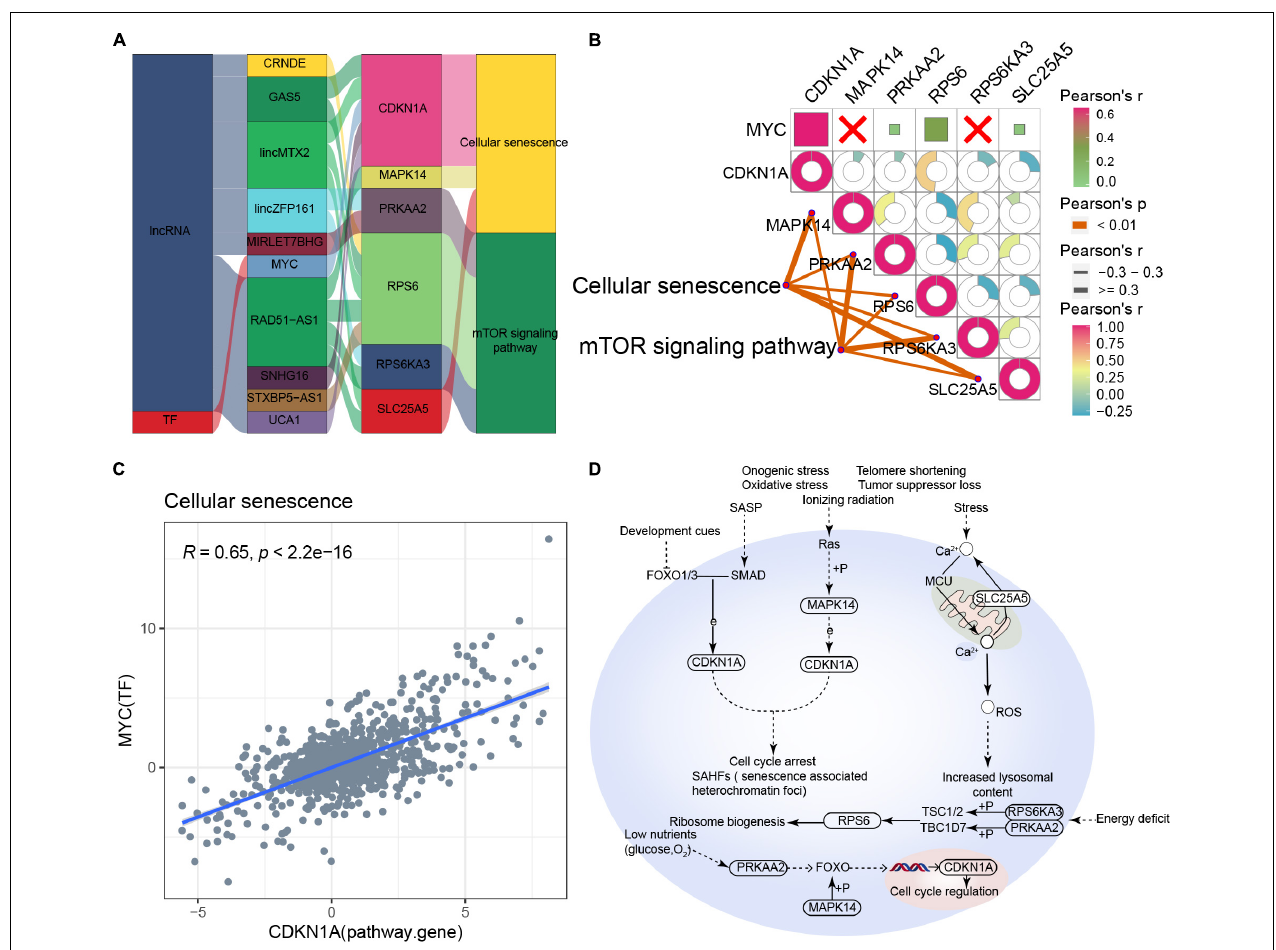
FIGURE 6 | Potential regulatory mechanism of cellular senescence-type Alzheimer’s disease (AD). (A) Sankey diagram showing the pathway of cellular senescence-type AD regulated by long non-coding RNAs (lncRNAs) and transcription factors (TFs) identified by the RNAInter and TRRUST databases. (B) Correlation pathway diagram of the gene–pathway, gene–gene, and TF–gene correlations. (C) Correlation scatter plot of the correlation between the TF MYC and the target gene CDKN1A. (D) Potential regulatory mechanism of cellular senescence-type